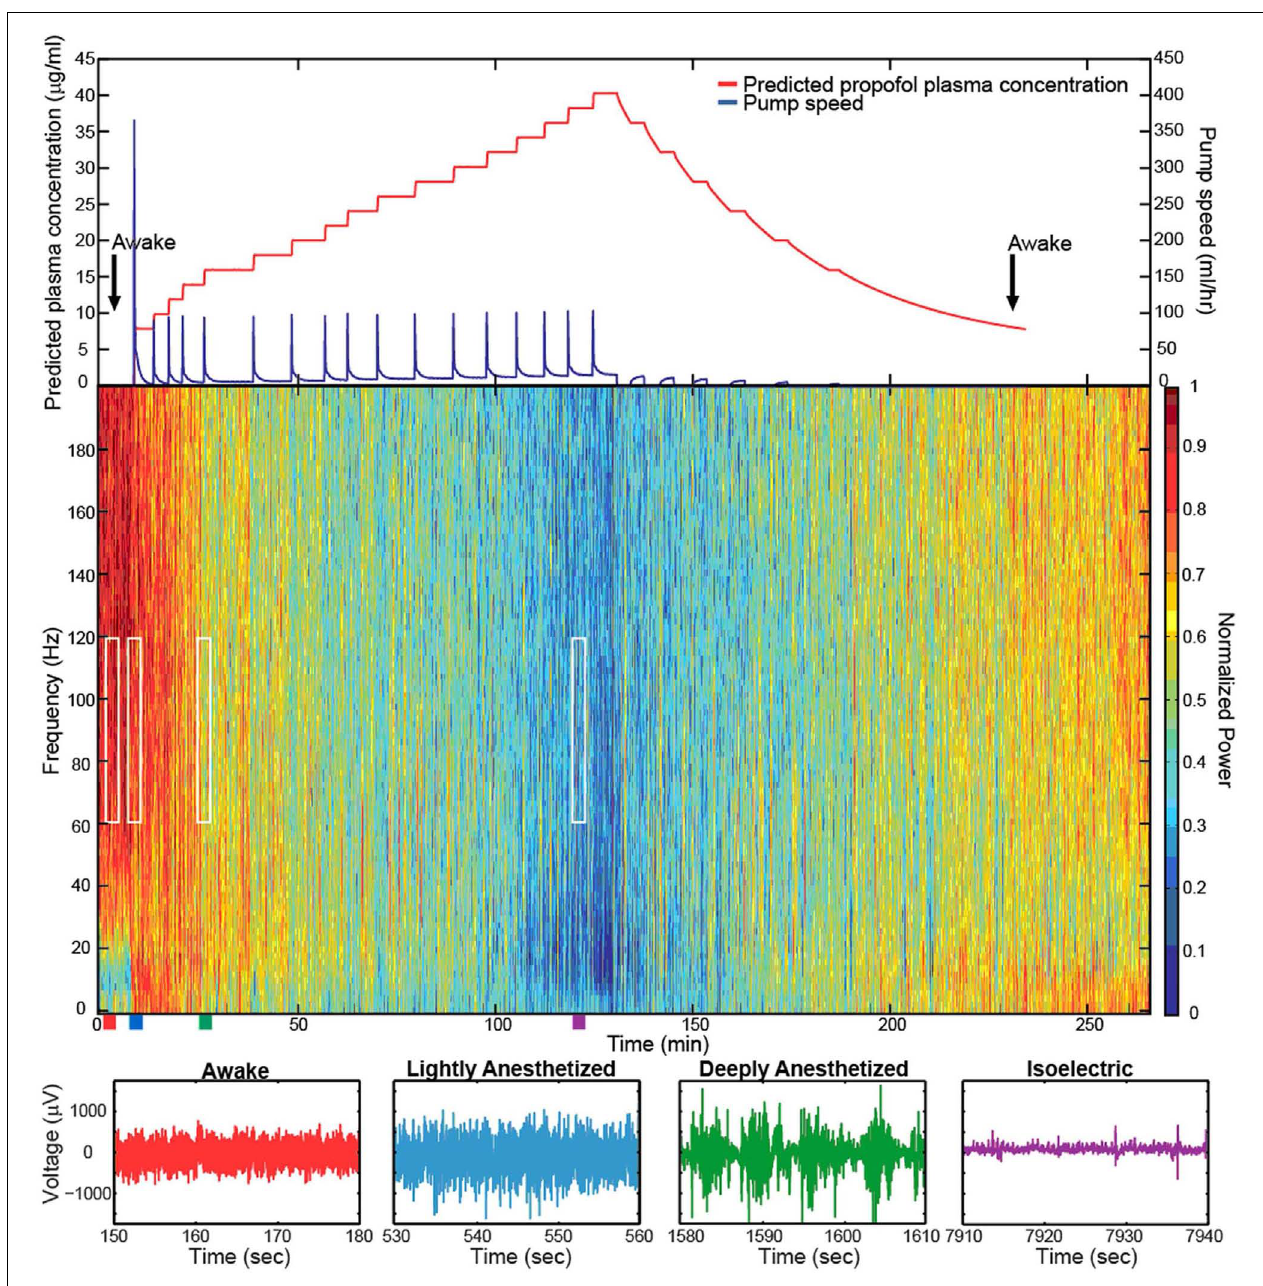
level of anesthesia. Red represents the awake state. Blue represents the lightly anesthetized state. Green represents the deeply anesthetized state. Purple represents the isoelectric state.White rectangles indicate the time periods and frequency bands chosen for the average power calculations across the array.With very high propofol concentrations, power in the LFP decreased across all frequency bands. After the peak propofol concentration is reached and the propofol concentration decreases, the power in the LFP